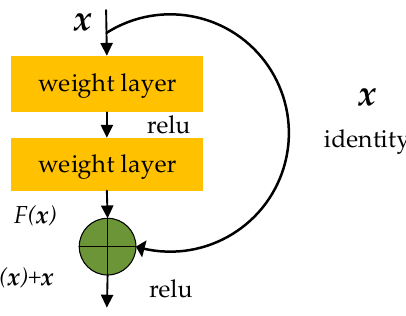
Figure 8. The basic structure of ResNet.